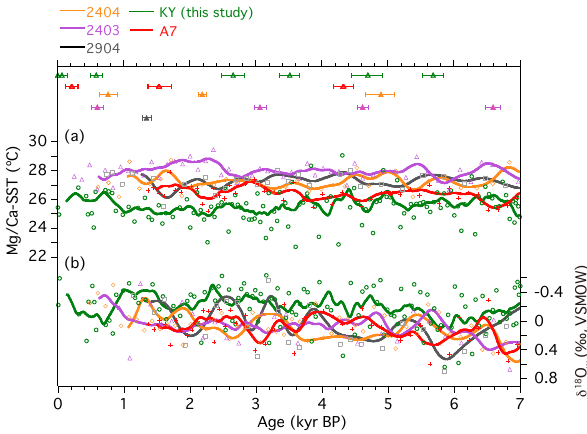
Figure 7. Diagrams show temporal changes in (a) Mg / Ca-derived SST and (b) δ 18 O w during the last 7kyr. Gray, purple, orange, red, and green lines represent 300-year average for 2904 (Steinke et al., 2011), 2403 (Lin et al., 2006), 2404 (Chen et al., 2010), A7 (Sun et al., 2005), and KY (this study), respectively. Original data are shown in the same colors for each core. Triangles and bars indicate age control points and errors of 2 σ